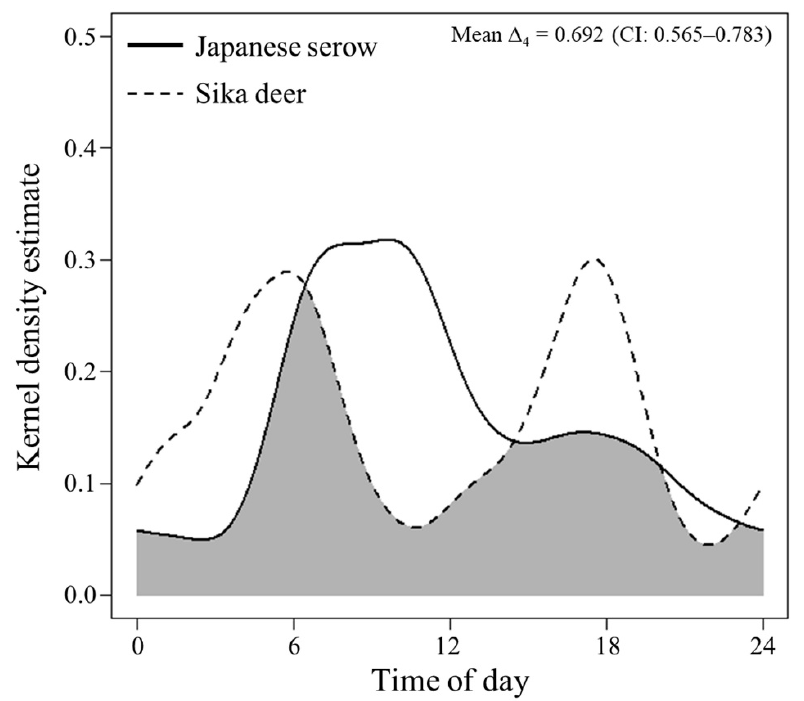
Figure 5. Comparison of daily activity patterns of Japanese serows and sika deer in Tsumagoi, central Honshu, Japan. The grey-shaded area indicates the mean coefficient of overlap, ∆ 4 , between both species.